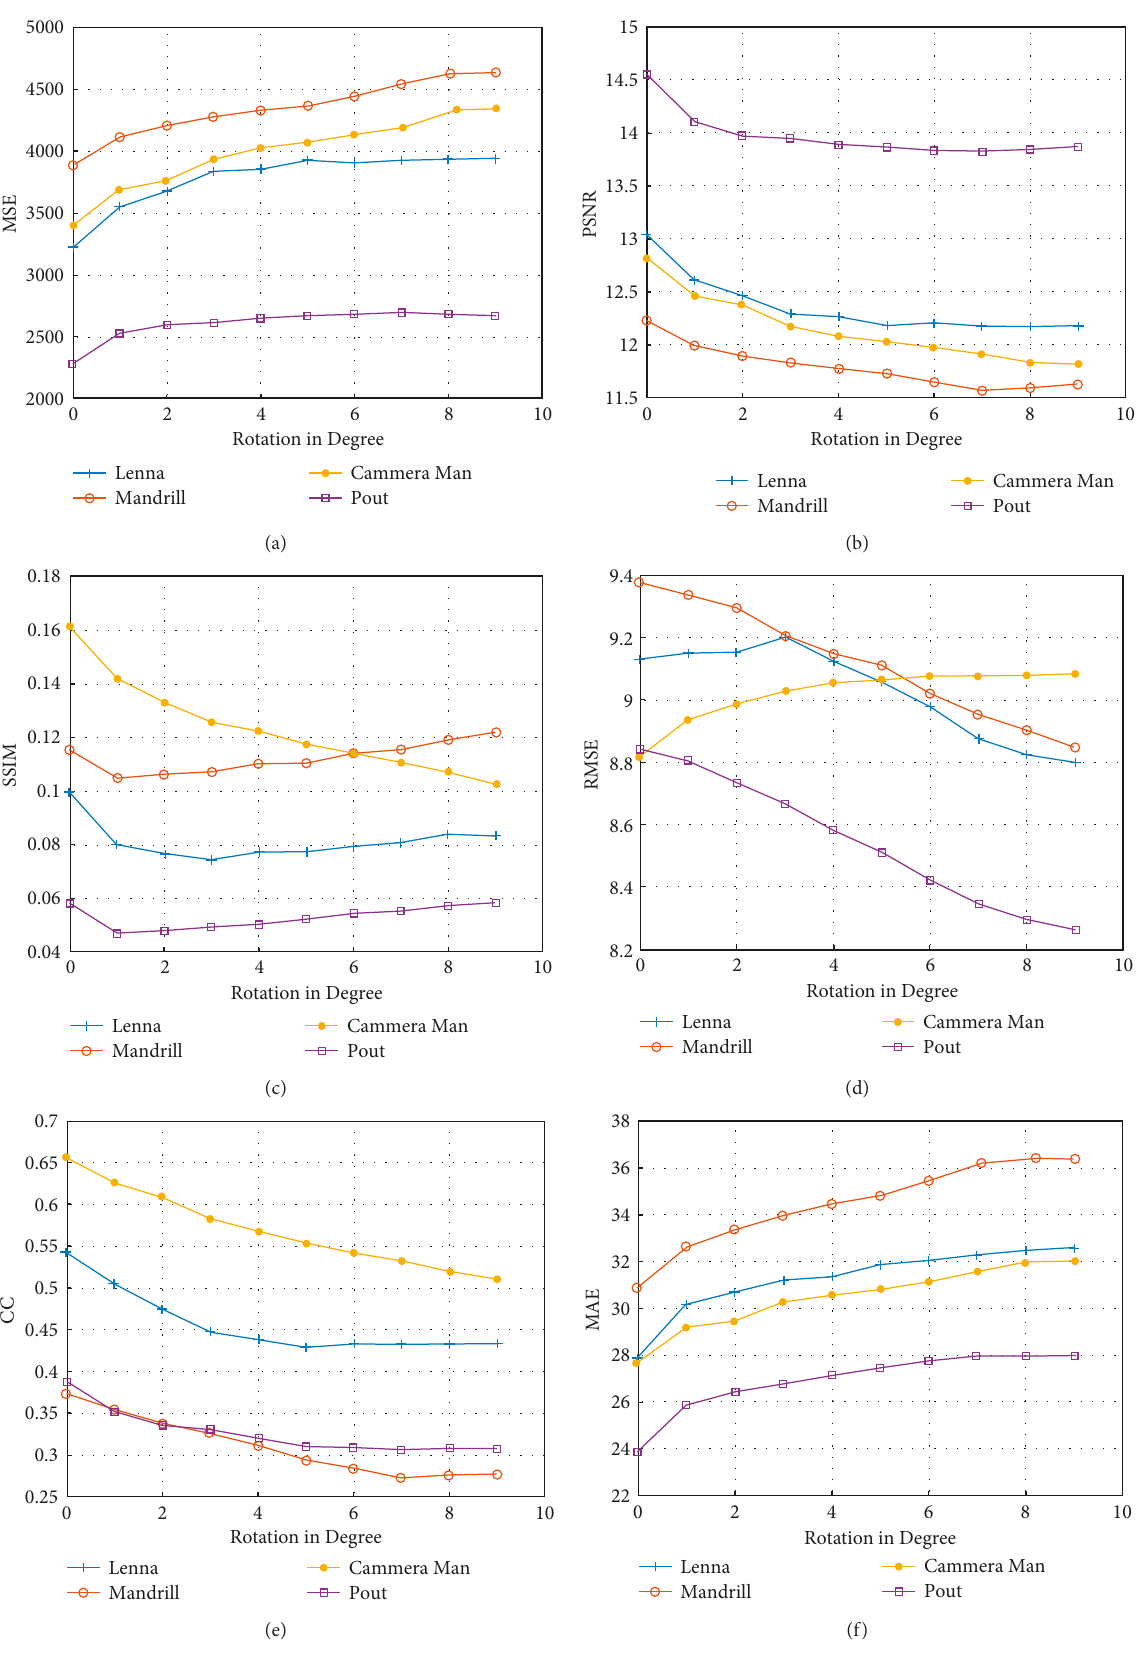
Figure 7: Performance comparison: (a) MSE, (b) PSNR, (c) SSIM, (d) RMSE, (e) CC, (f) and MAE based on rotation in